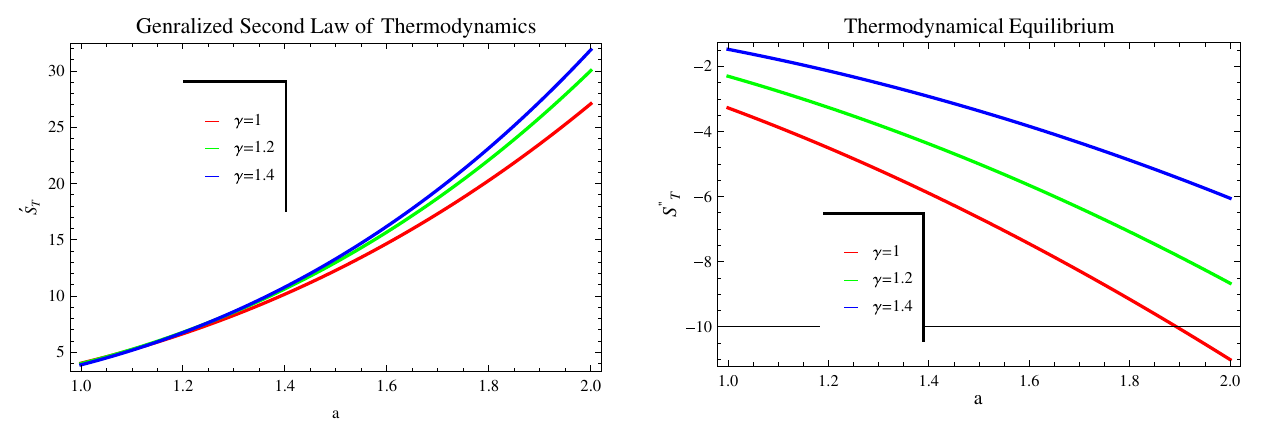
Fig. 1 Plot of S (cid:7) T versus a for Bekenstein entropy using k = 1 , λ = − 1 and b = 1